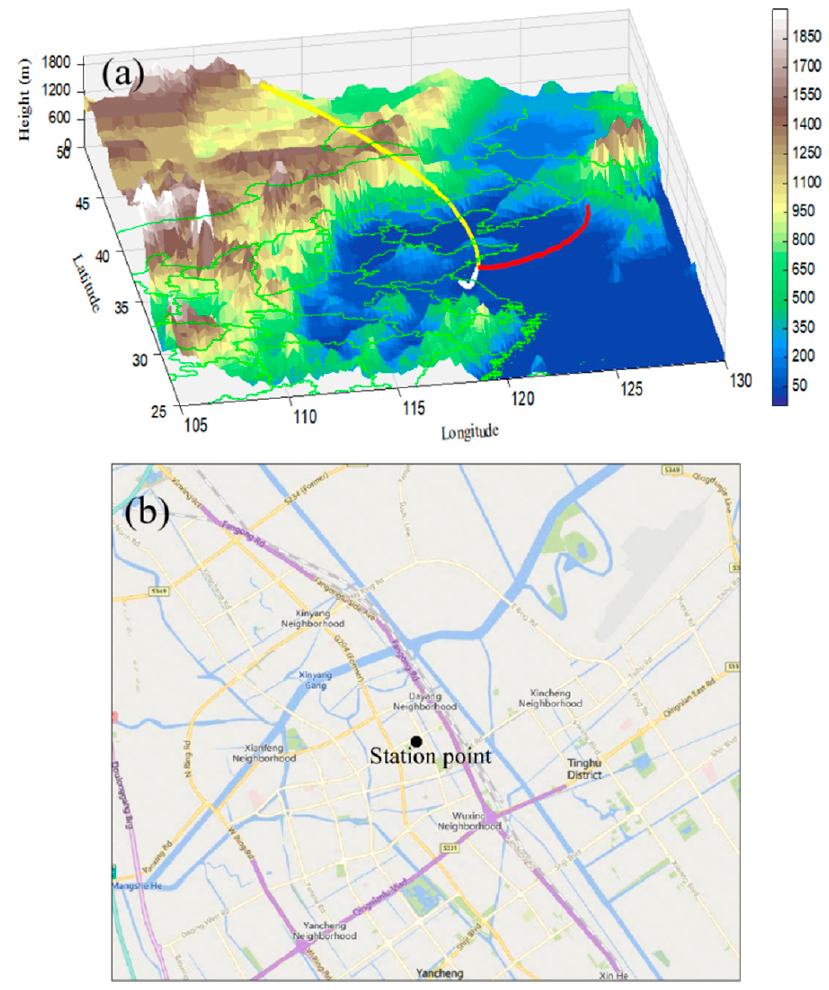
Figure 1. Schematic diagram of the observation point ( a ) is the 3D trajectory clustering of 500 m height during the observation period, where the white, yellow and red line segments are trajectories 1, 2 and 3, respectively; ( b ) is the schematic diagram of geographical location of sampling points). Before the research, the quality control of PM 2.5 data was carried out: 1. Remove the missing and incorrect values (PM 2.5 concentration ≤ 0) of PM 2.5 concentration in the original data; 2. The 3 σ rule method was used to remove the outliers; 3. If the number of samples is less than 80% of the total number when calculating the daily average and monthly average PM 2.5 concentration, it would be considered